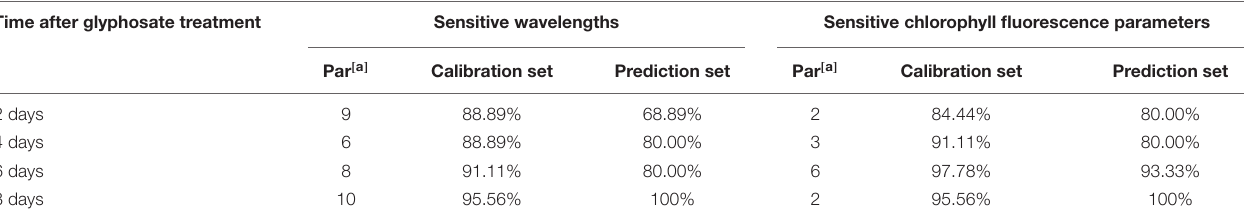
[a] Model parameters indicate the optimal number of latent variables for establishing the partial least squares discriminant analysis calibration model.